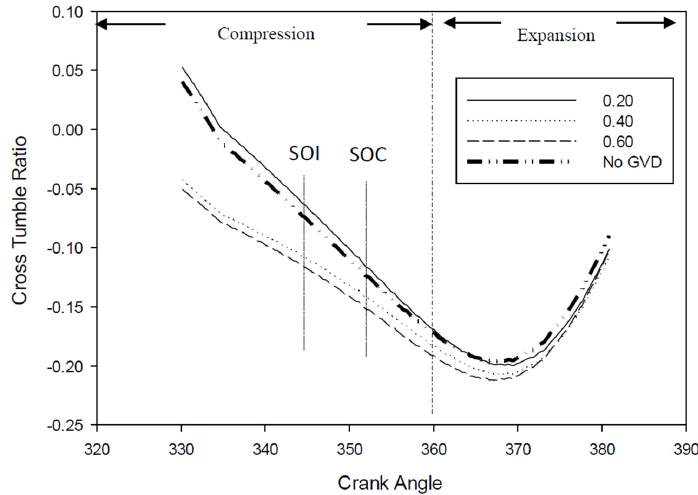
Figure 11. Cross tumble ratio (R CT ) against the crank angle ( θ ).